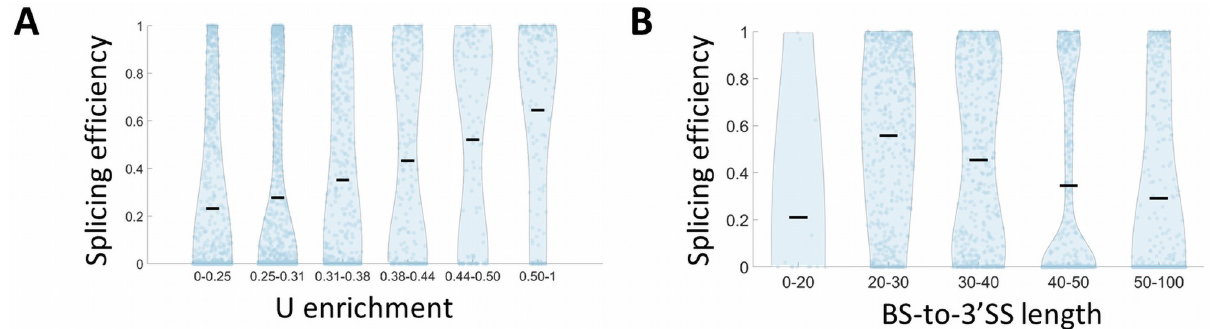
Fig 4. BS-to-3’SS nucleotide content and length affect splicing efficiency. A. Splicing efficiency distribution for library variants utilizing consensus splice sites’ sequences, is binned according to poly uracil tract enrichment, which is calculated as the U content at a window of 20 nucleotides upstream to the 3’SS. We observe a significant positive correlation, compared to a non-significant correlation for Y-rich elements (S3A Fig) (Pearson r = 0.95 p- value = 4 � 10 − 3 ). B. Splicing efficiency distribution for library variants utilizing consensus splice sites’ sequences, is binned according to BS-to-3’SS length. We notice that splicing efficiency is significantly higher for length of 20–30 nt compared to all other bins (t-test, p-value < 10 − 4 ), and a negative correlation between splicing efficiency and BS-to-3’SS length for lengths ≧ 20 (Pearson correlation, r = -0.14 p-value < 10 − 10